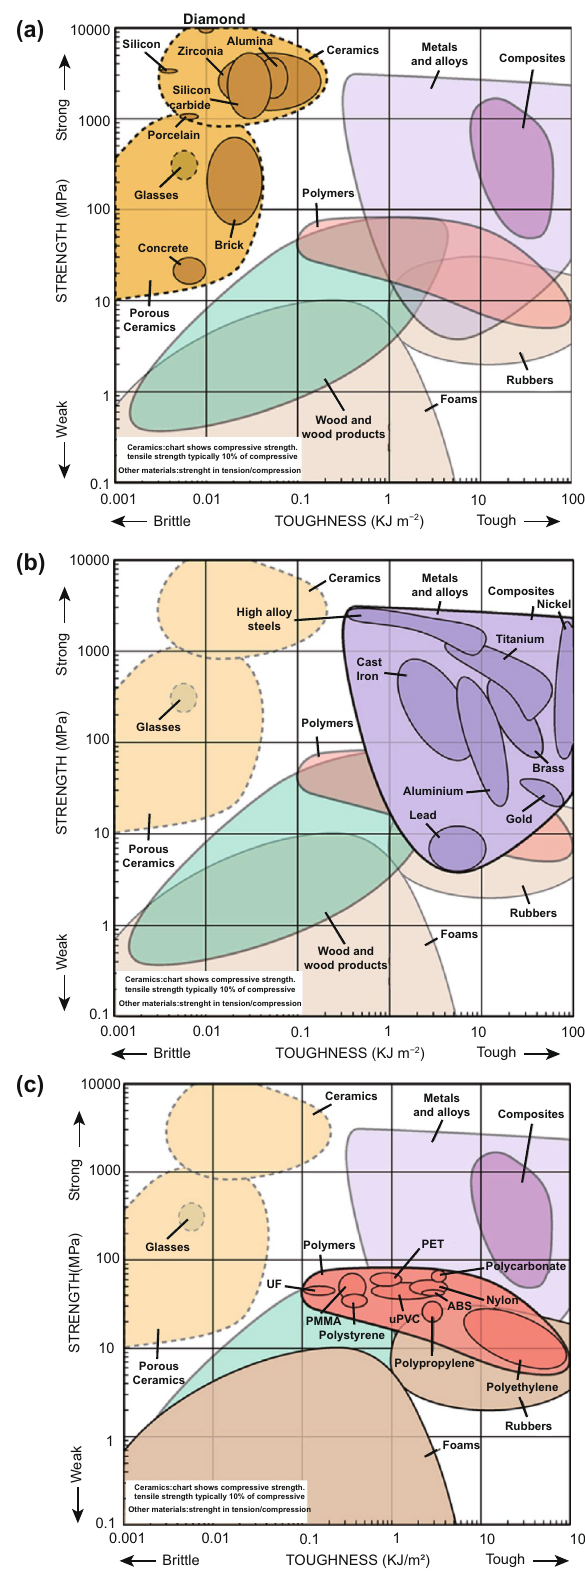
Fig. 6 Strength versus toughness for a ceramics, b metals and c poly- mer materials, which is used to fabricate microneedles (MNs). The diagram indicates the strength (MPa) and toughness (kl m −2 ) ranges for several materials used in the MN fabrication process. For MNs to successfully insert into the skin, materials should be both strong and tough to withstand natural elasticity of skin. Weak and brittle mate- rials are unlikely to insert without bending or breaking, potentially leaving MN material within the skin. Reprinted from Ref. [87] with permission from Elsevier